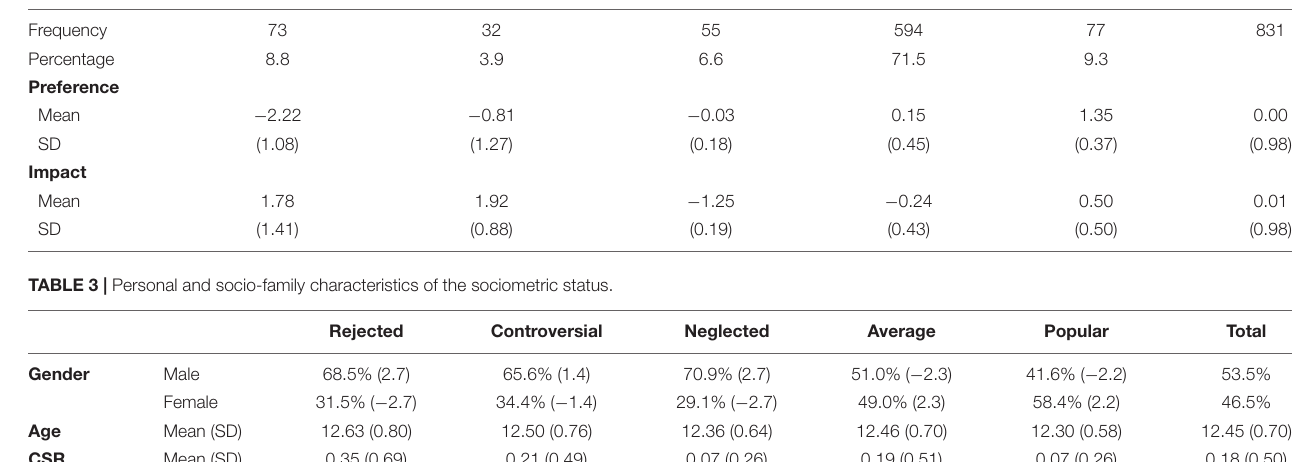
TABLE 2 | Distribution and descriptive statistics of the sociometric status. Rejected